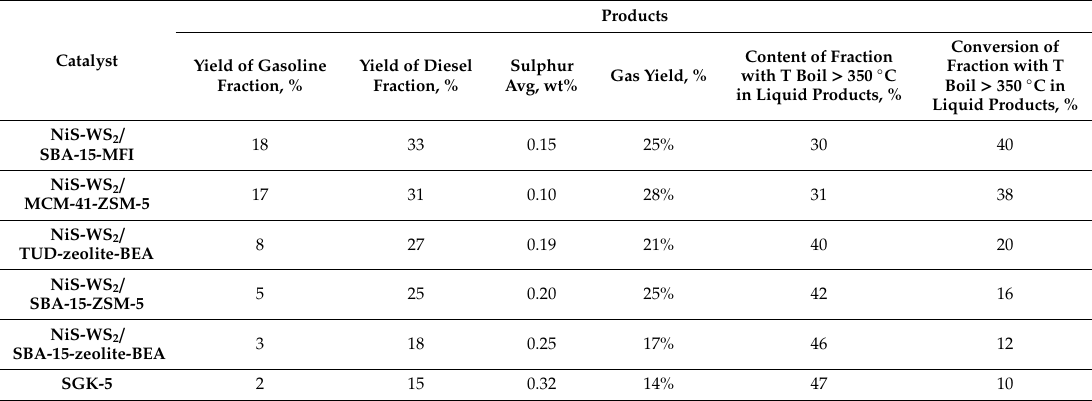
Table 3. Results of oil sludge hydrocracking experiments with the use of micro / mesoporous catalysts. Products Catalyst Yield of Gasoline Yield of Diesel Sulphur Fraction, % Fraction, % Avg,